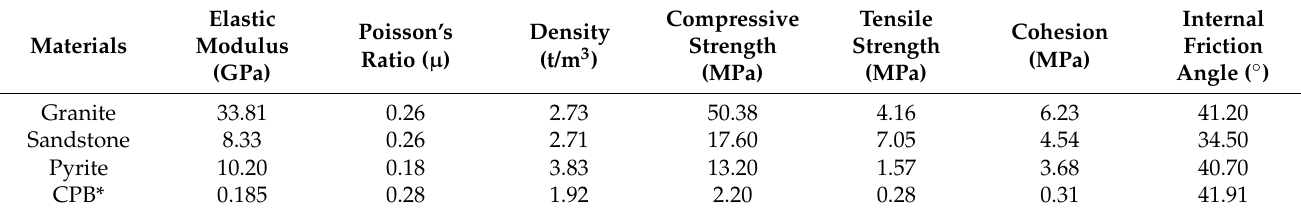
Table 1. Mechanical parameters of underground mining rock and underground backfill.